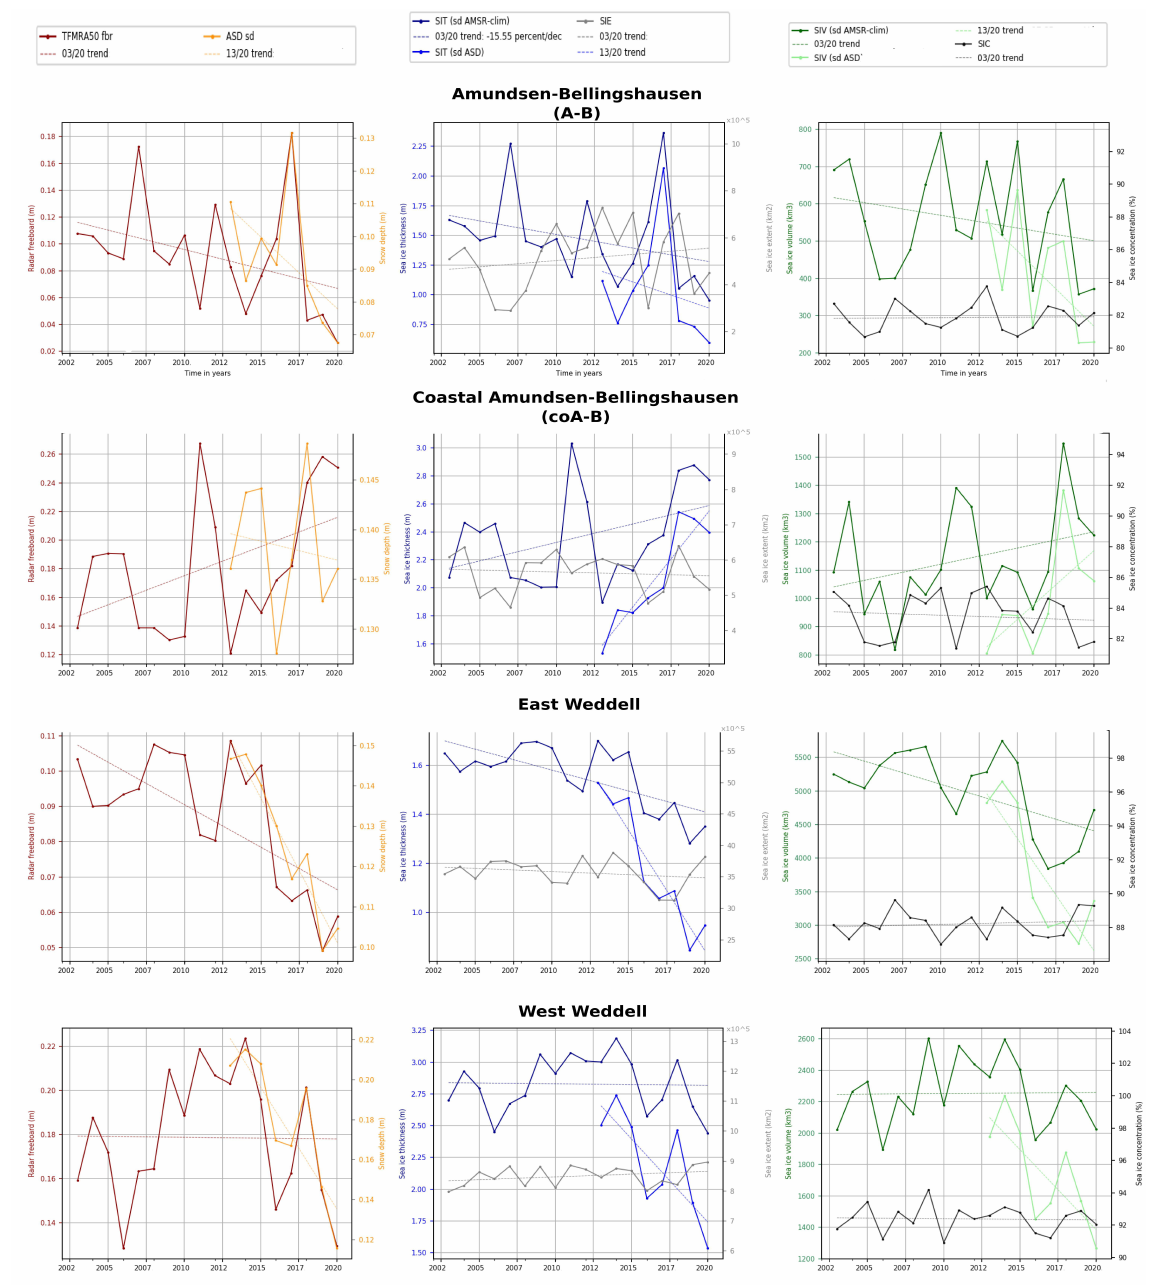
Figure 10. Same as for Figure 9 for 4 of the regions defined by Figure